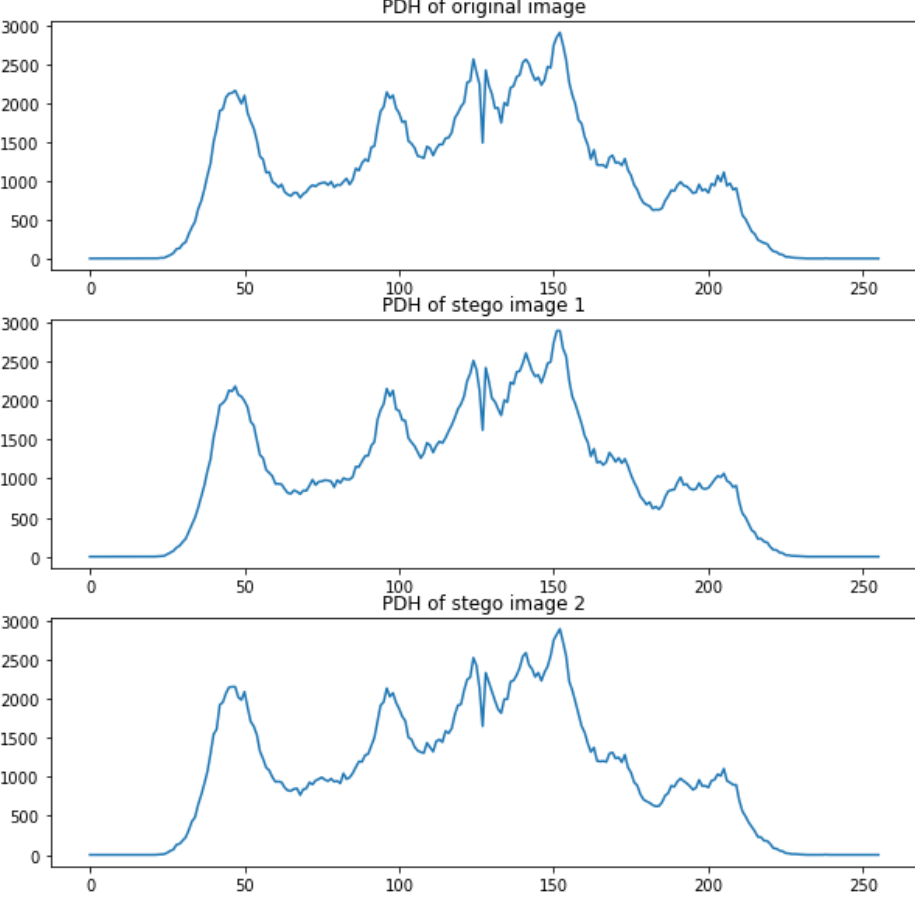
Figure 13. PDH analysis of the original image and the two stego images.